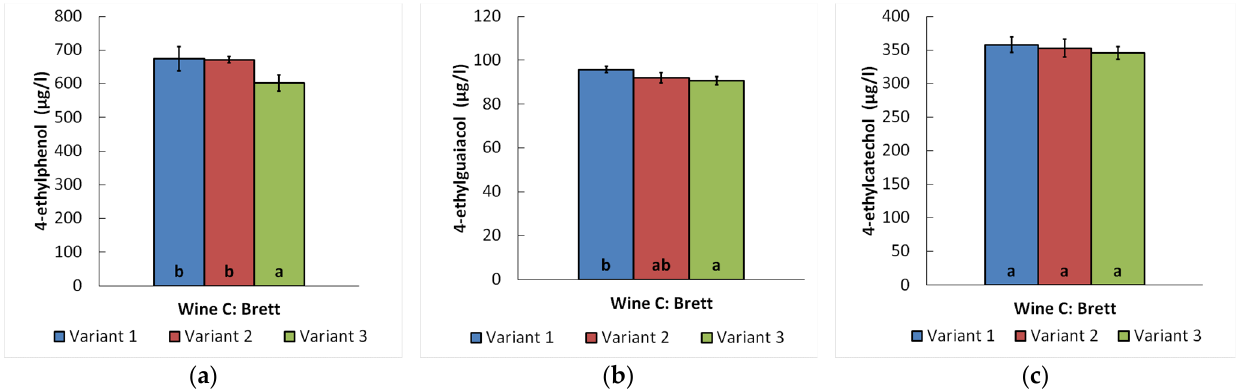
Figure 2. Reduction in impact compounds of the wine faults by filtration with conventional EKS layers (variant 2) and Fibrafix ® TX layers (variant 3) compared with the control sample (variant 1) in the small-scale test. Wine A was spiked with geosmin, wine B with TCA, and wine C with impact compounds of the “animal” phenolic character (Brett): ( a ) 4-ethylphenol; ( b ) 4-ethylguaiacol; ( c ) 4- ethylcatechol. Significance test by simple ANOVA and post hoc test Tukey B test. Same letters mean no significant difference based on significance level p ≤ 0.05 with alphabetical order, starting with a (smallest value) to c (largest value).